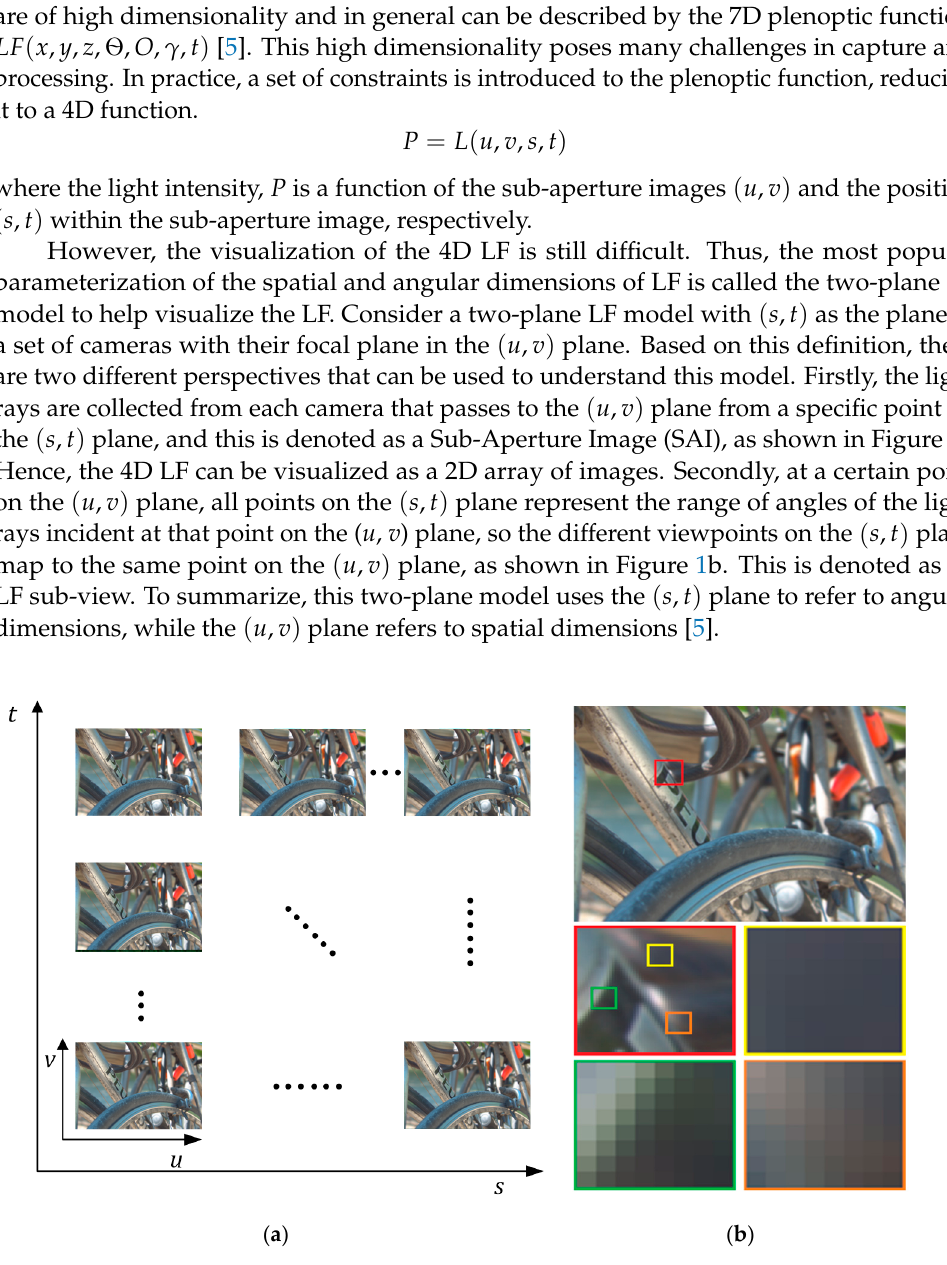
Figure 1. ( a ) Sub-aperture image (SAI) represented by the (𝑠, 𝑡) and (𝑢,𝑣) planes; ( b ) LF sub-view represented by gathering samples with fixed (𝑢,𝑣). represented by gathering samples with fixed ( u , v )